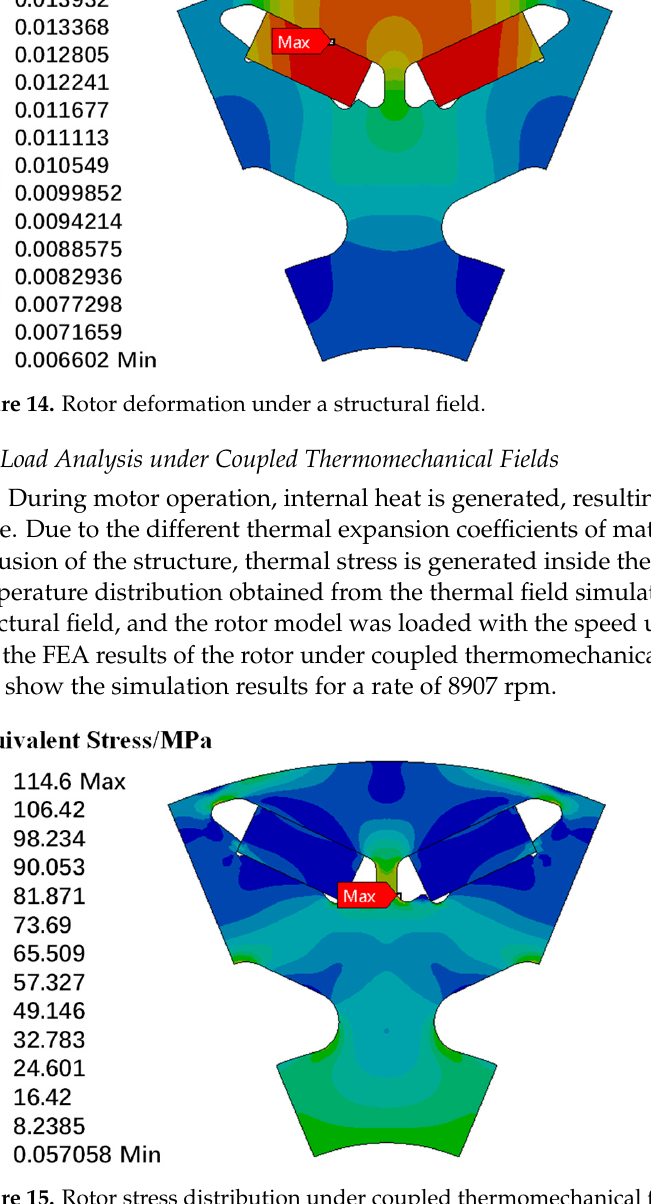
Figure 14. Rotor deformation under a structural field.